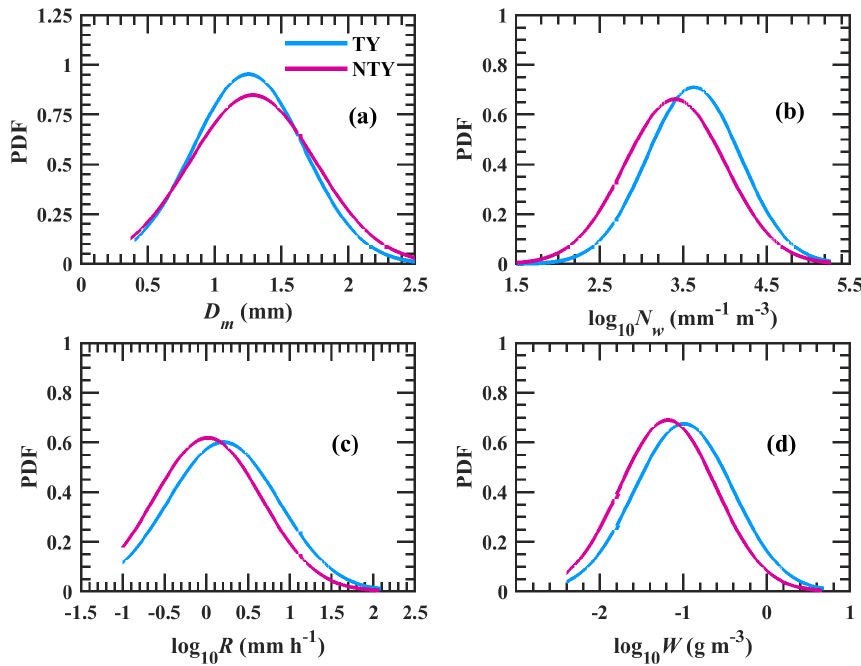
Figure 4. The probability distribution functions (PDFs) of (a) mass-weighted mean diameter, D m (mm), (b) log 10 N w ( N w is the normalized intercept parameter in mm − 1 m − 3 ), (c) log 10 R ( R is the rainfall rate in mmh − 1 ), and (d) log 10 W ( W is the liquid water content in gm − 3 ) for typhoon (TY) and non-typhoon (NTY)